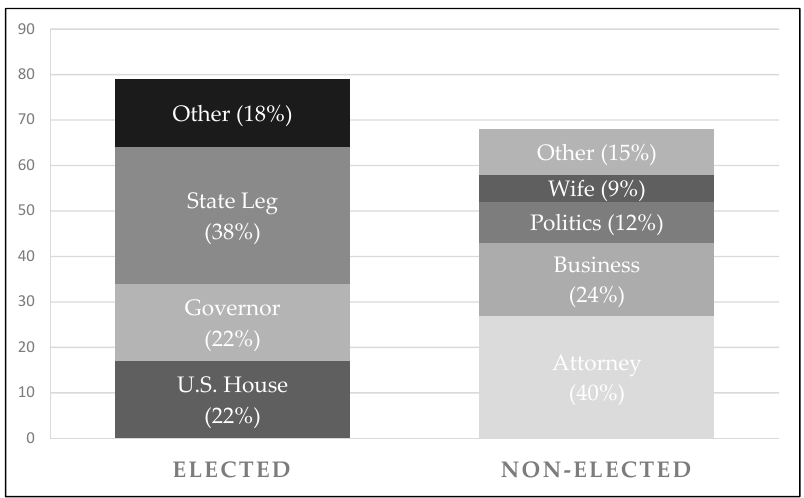
Figure 1. Positions Held Prior to Appointment.